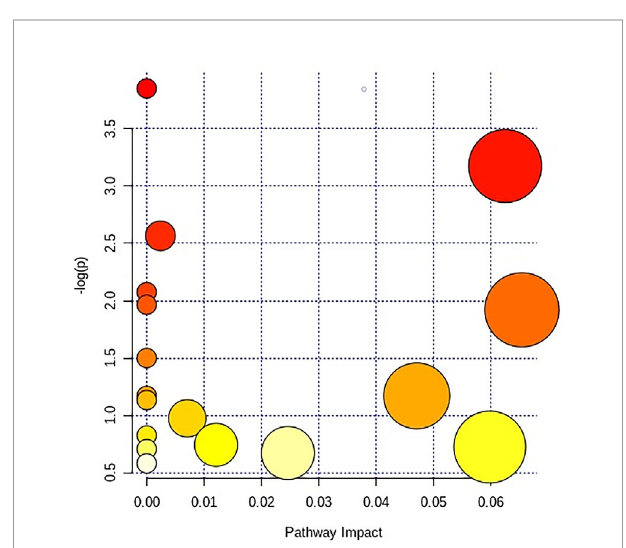
FIGURE 10 | The different canonical pathways regulated by HNK in the current study. The colors refer to the impact score of the metabolic pathways. The identi fi ed metabolic pathways are represented as circles, whose color and size are based, respectively, on the p -values, calculated with the hypergeometric test (from white to deep red) and on the pathway impact values, from the smallest to the largest. Summary pathway analysis is reported in Supplementary Table S3